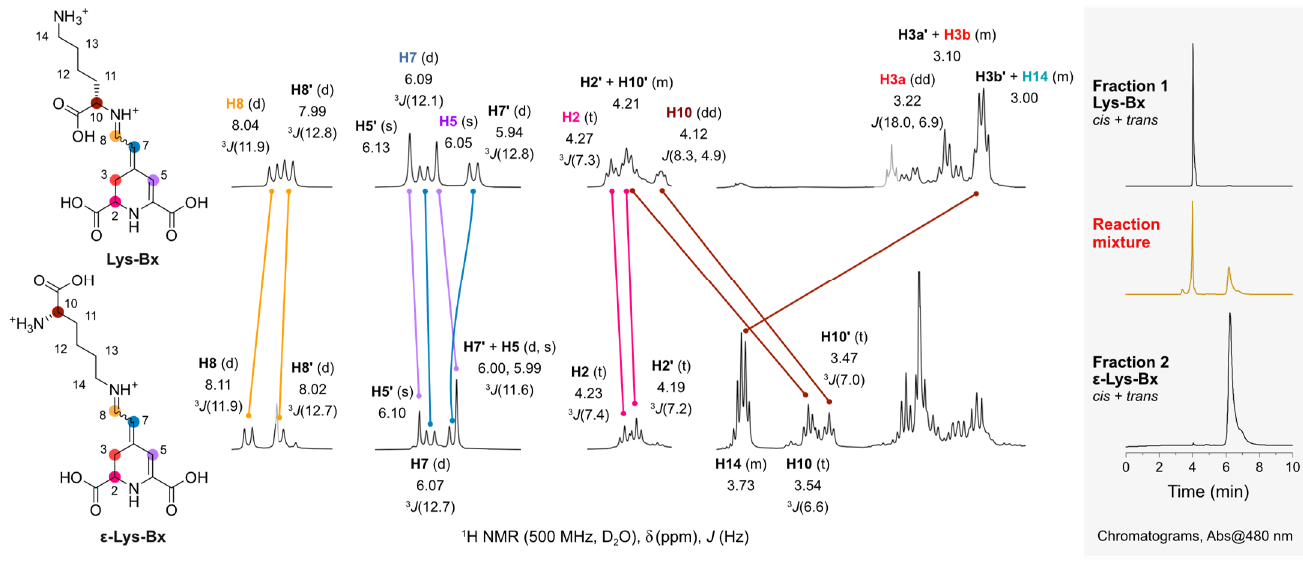
Figure 3. 1 H NMR analysis of Lys-Bx and ε-Lys-Bx. Atom numbering in the amino acid chain was kept identical for clarity. Signals in grey are of impurities. Full spectra are presented in Figures S28 and S29.